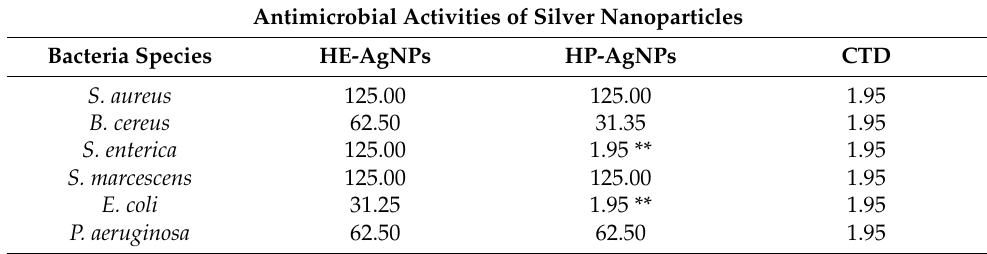
Table 2. MIC values of the antimicrobial activities of AgNPs and the standard in µ g/mL. Antimicrobial Activities of Silver Nanoparticles Bacteria